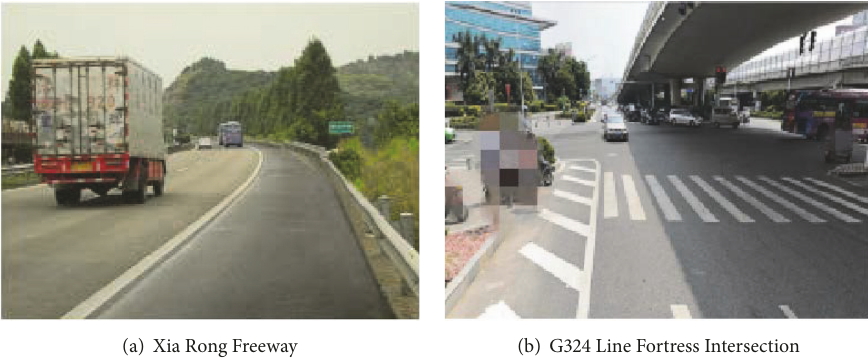
Figure 2: Photos of experimental highway and example of